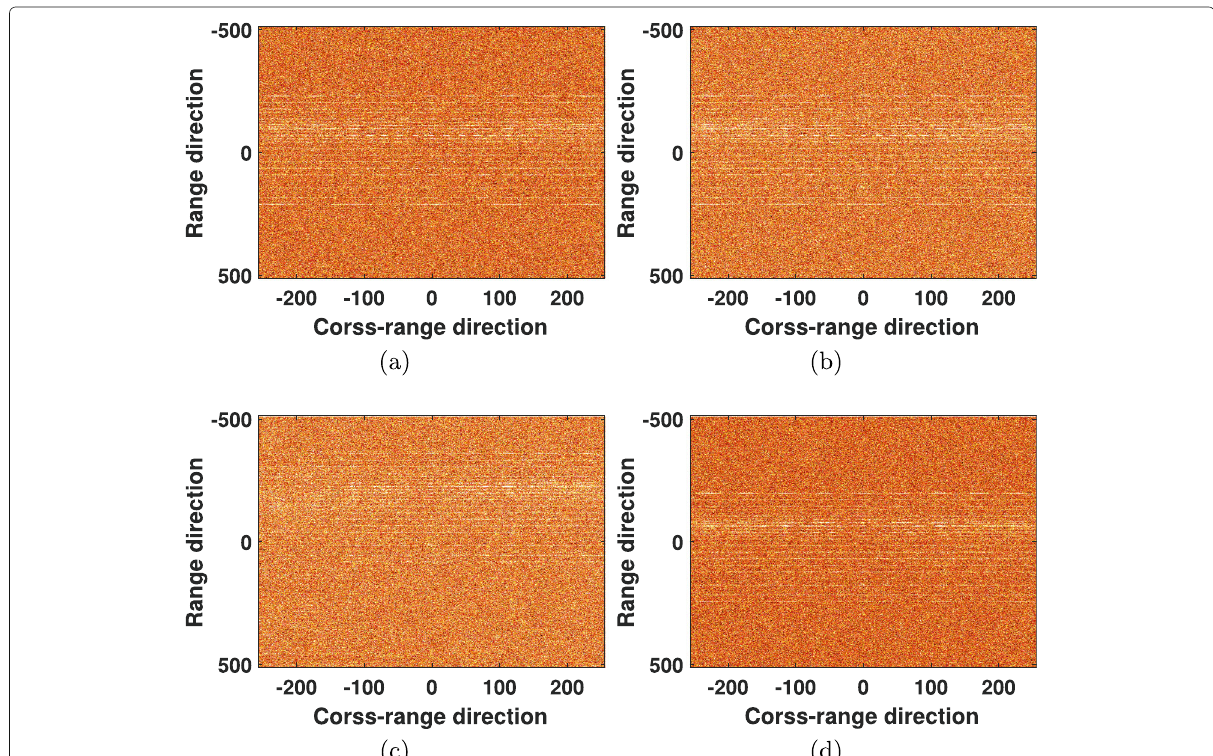
Fig. 4 Alignment results of the different methods under a − 10 dB SNR. a The range profiles without envelope deviation, b the alignment result of the proposed algorithm, c the alignment result of the ACM, and d the alignment result of the